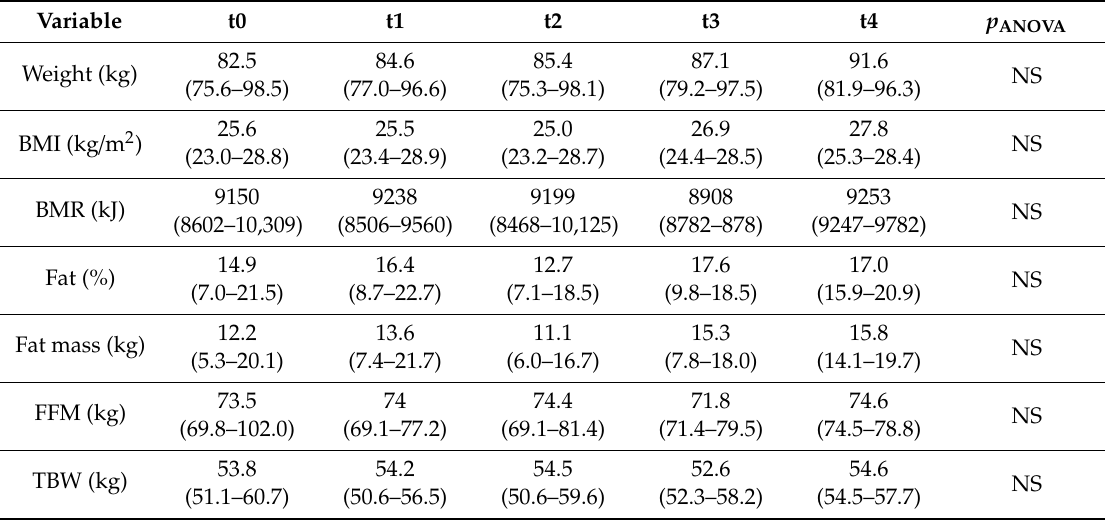
Table 2. Participants’ body composition variables during the training